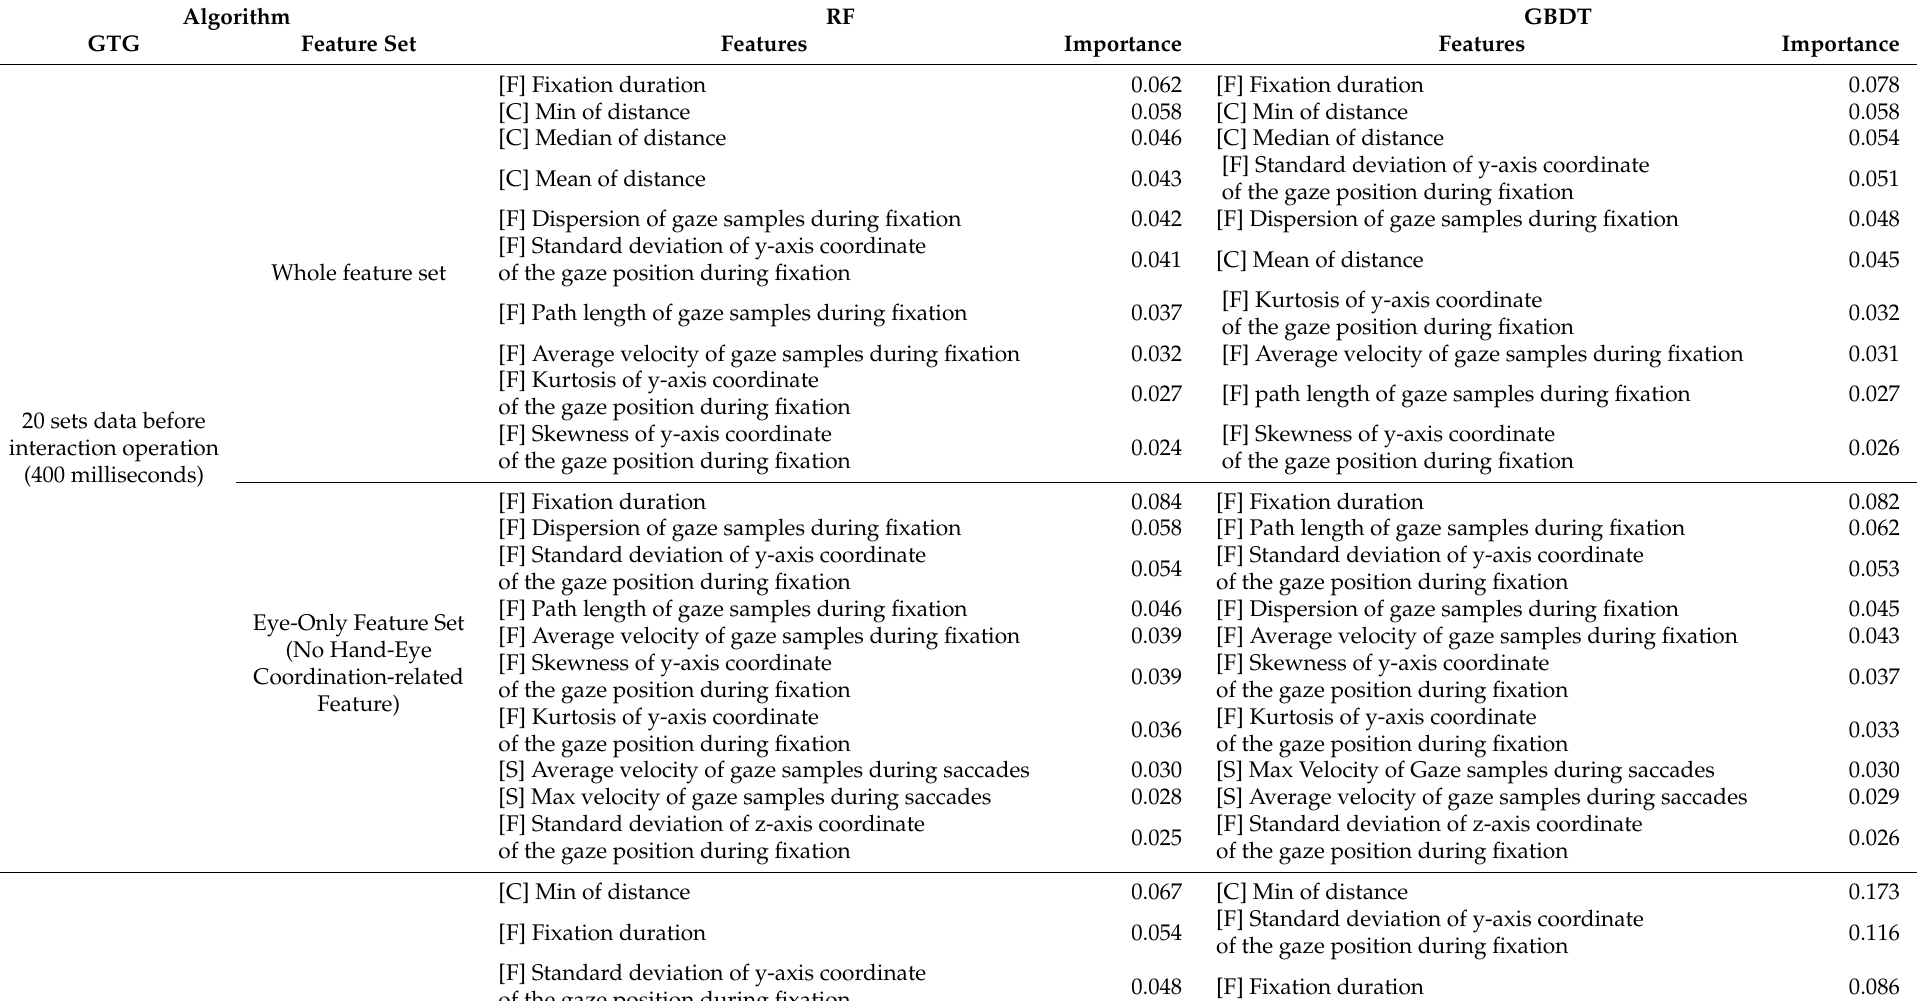
Table 6. Top-ten importance features based on Random Forest and GBDT feature importance scores of three-class